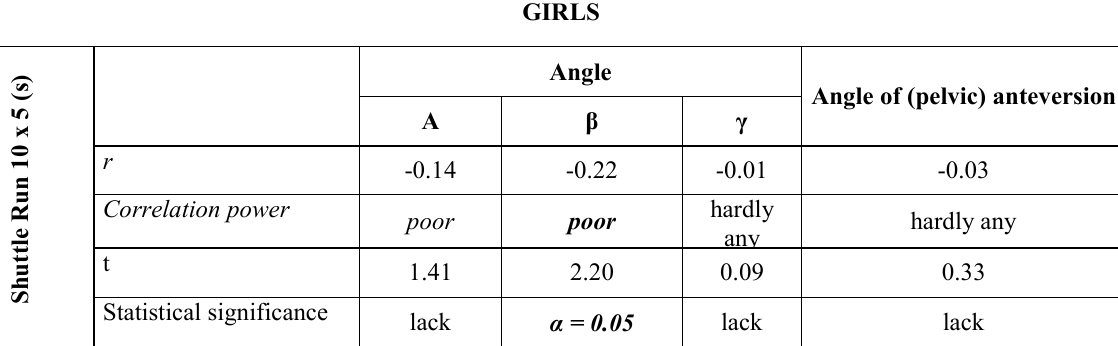
Correlations occurring between the angles characteristic of anterior-posterior pelvic tilts (upper thoracic - α, thoracic- lumbar - β, sacral-lumbar γ) and the angle of pelvic anteversion in the sagittal plane and the number of points scored in the 10 x 5 m shuttle run test in the girls involved in the